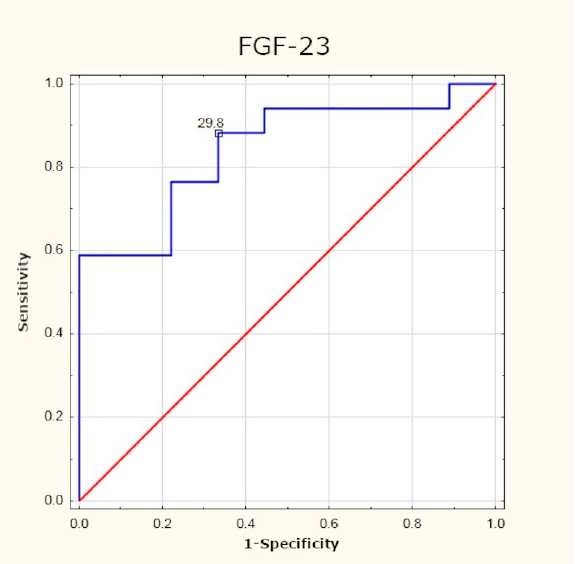
Figure 1. Plasma concentrations of FGF-23.